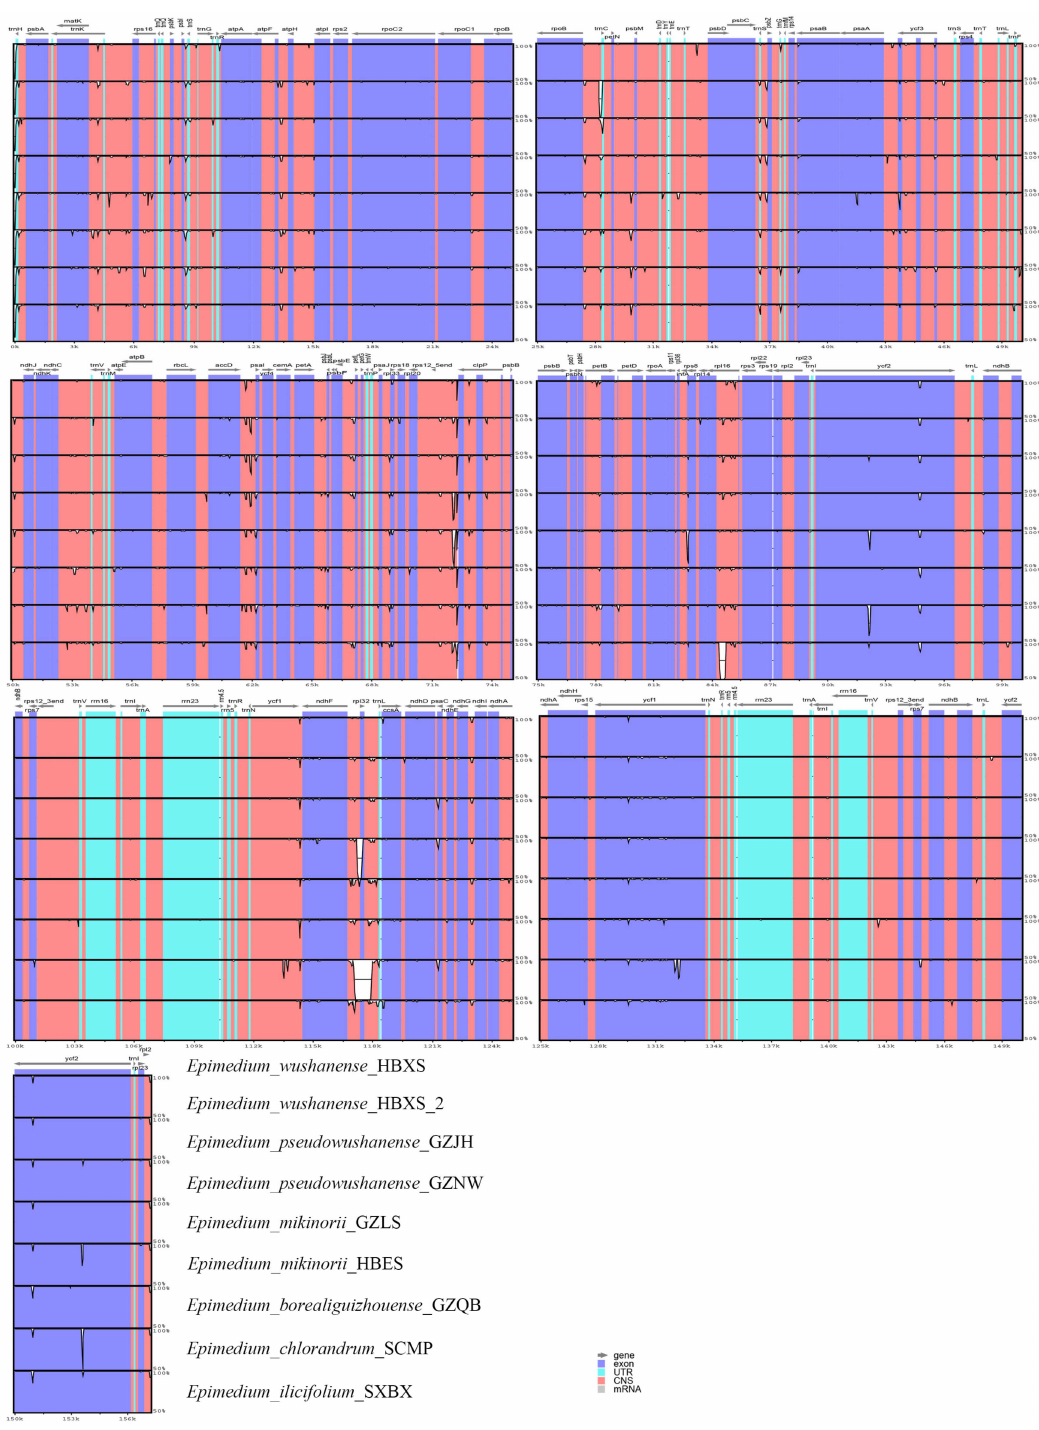
Figure 5. Sequence identity plots comparing nine Epimedium plastid genomes with E. wushanense as a